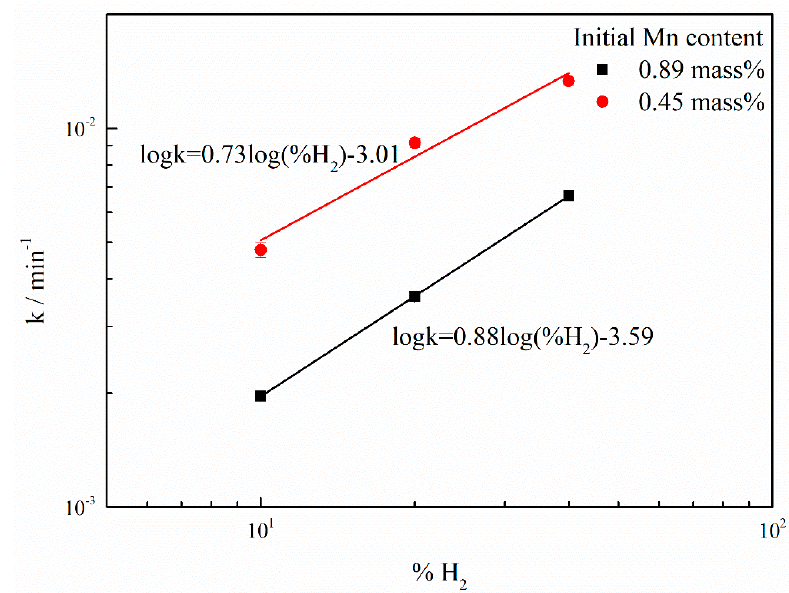
Figure 6 Dependence of the apparent manganese content reduction rate constant ( 𝑘 (cid:3014)(cid:3041) ) on the hydrogen volume fraction (% H 2 ) for different initial manganese contents (0.89 mass% and 0.45 mass%).